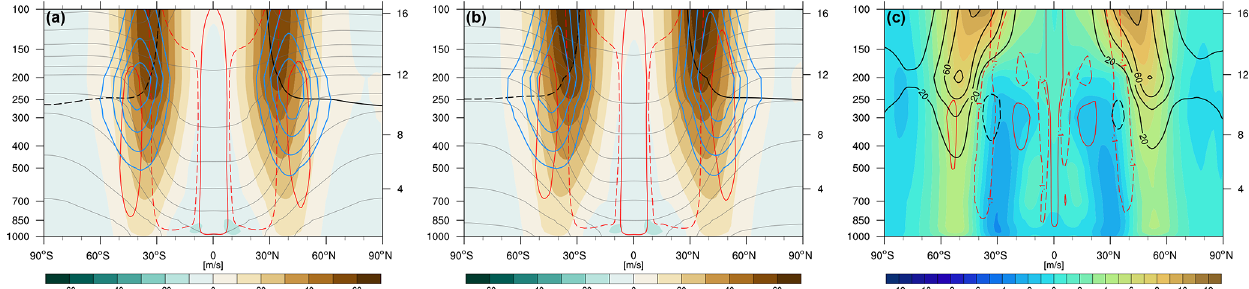
Figure B1. Zonal mean fields in the (a) control and (b) control + 4K simulations and (c) their difference for the zonal wind speed (shading; ms − 1 ), vertical wind speed (red contours, negative dashed; cms − 1 ), and eddy kinetic energy (blue contours in a and b and black contours in c ; Jkg, − 1 ). Additionally shown in (a) and (b) is the dynamical tropopause (black contour; 2PVU) and potential temperature (gray contours).